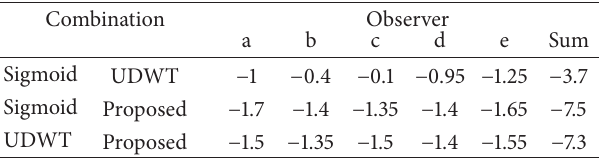
Table 2: Results of chest radiograph scoring for the three combina- tions by the five